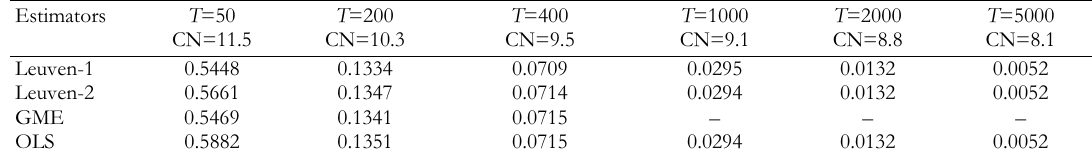
Monte Carlo experiment N. 1: model without intercept. MSEL for rival estimators. 100